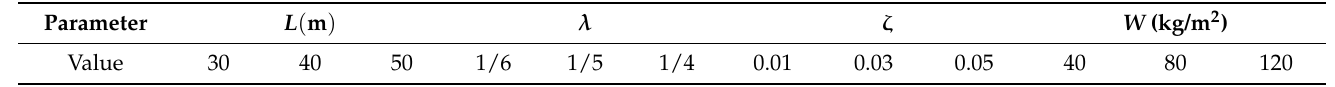
Table 2. Parameter values of the